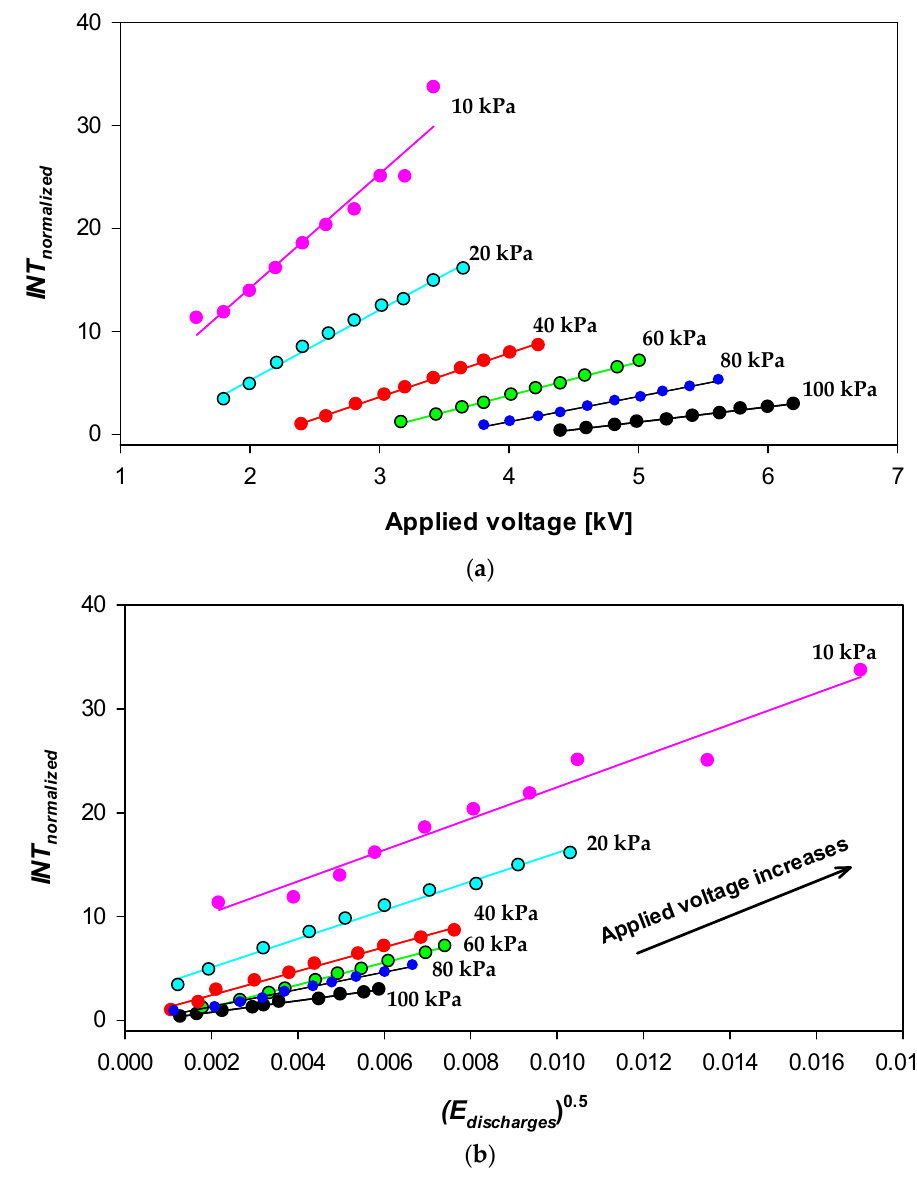
Figure 6. Experimental results. ( a ) Correlations between the normalized intensity of the digital images of the discharges and the applied voltage. ( b ) Correlations between the normalized intensity of the digital images of the discharges and the square root of the electric energy dissipated by the discharges.